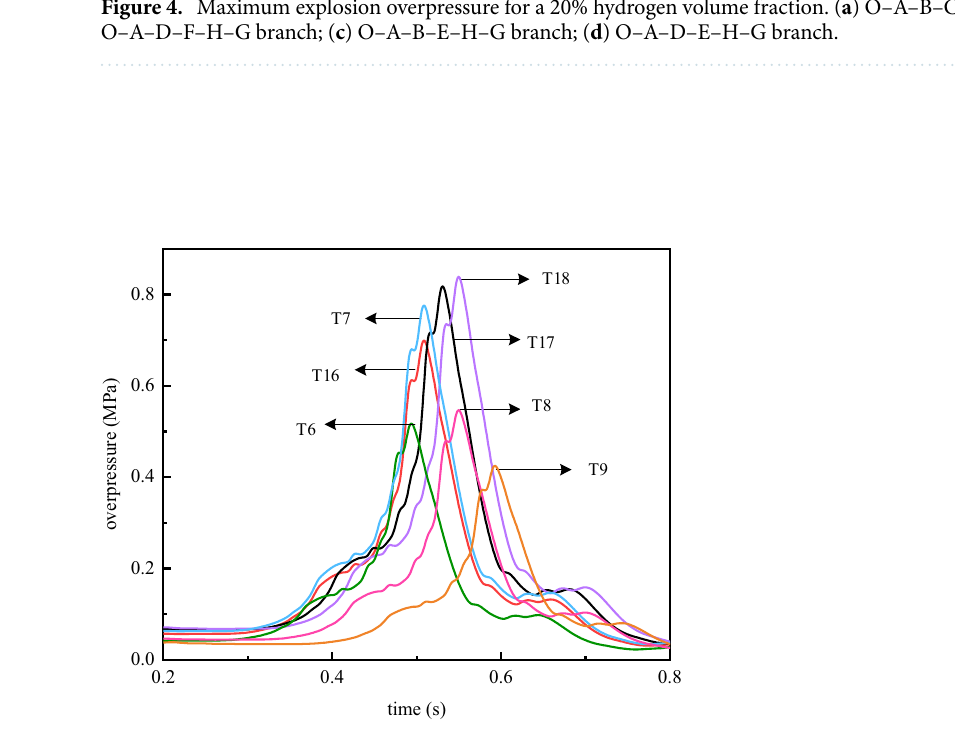
Figure 5. Maximum explosion overpressure at the measuring point in the middle of the complex pipe